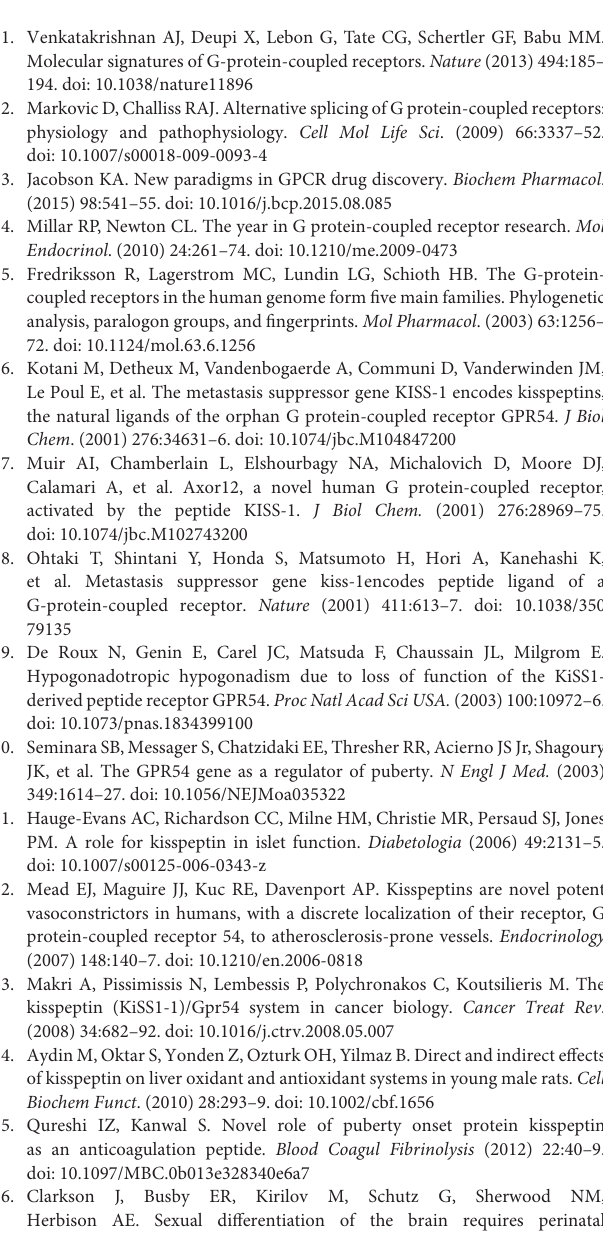
Supplementary Figure 2 | Homology model of the Kissr2. Pejerrey Kiss1 sequence is shown in red. Supplementary Figure 3 | Homology model of the Kissr3. Pejerrey Kiss2 sequence is shown in red. Supplementary Figure 4 | Weblogo 3 (http://weblogo.threeplusone.com/) representation of the sequence alignments in teleost fish peptides. (A) Teleost